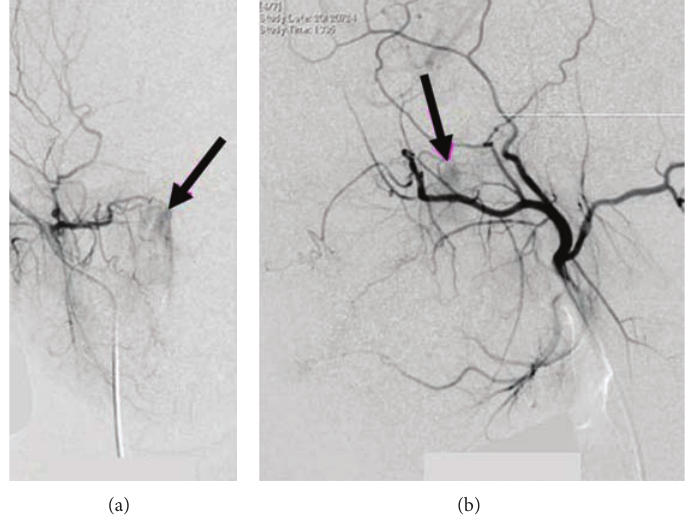
Figure 3: Frontal (a) and lateral (b) right external carotid angiograms showing faint tumor staining (arrows).